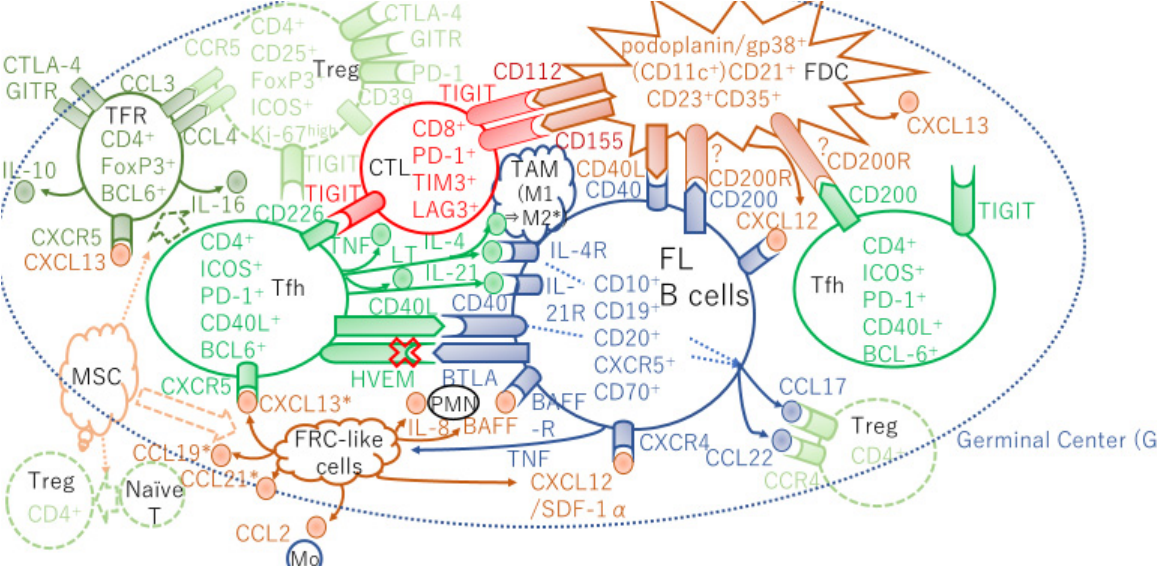
Figure 1. Lymphoid stromal cells and CD4 + T cells supporting FL B-cell growth and allowing escape from immune surveillance with cytokine/chemokine circuits in the GC. The disruption of inhibitory signals delivered to the BTLA receptor increases Tfh. HVEM loss trigger production of TNF family cytokines that activate the lymphoid stroma cells; FDCs and FRCs. FRC-like cells produce CCL19 and CXCL13 that recruits CXCR5 + Tfh. In turn, Tfh produce IL-4 and IL-21 providing mitogenic signals to FL B cells. TFRs produce CCL3 (MIP-1 α ) and CCL4 (MIP-1 β ) are chemotactic for Tregs. * TAM polarization by IL-4 [8] and CXCL13, CCL19, and CCL21 secreted by normal FRCs [9] were results from mice experiments. In mice, TFRs originate from naïve Tregs [10–12]. In contrast, human FL TFRs in part originate from Tfh cells [13]. CD200R was found to be expressed just on classical DC (CD11c + HLA-DR + ) from FL LNs. PMN, polymorphonuclear neutrophil; Mo, monocyte. Details in the text.